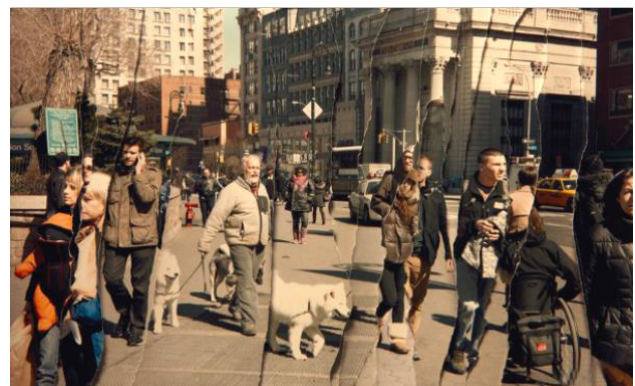
Figure 2. Scene montage (source: [28]).